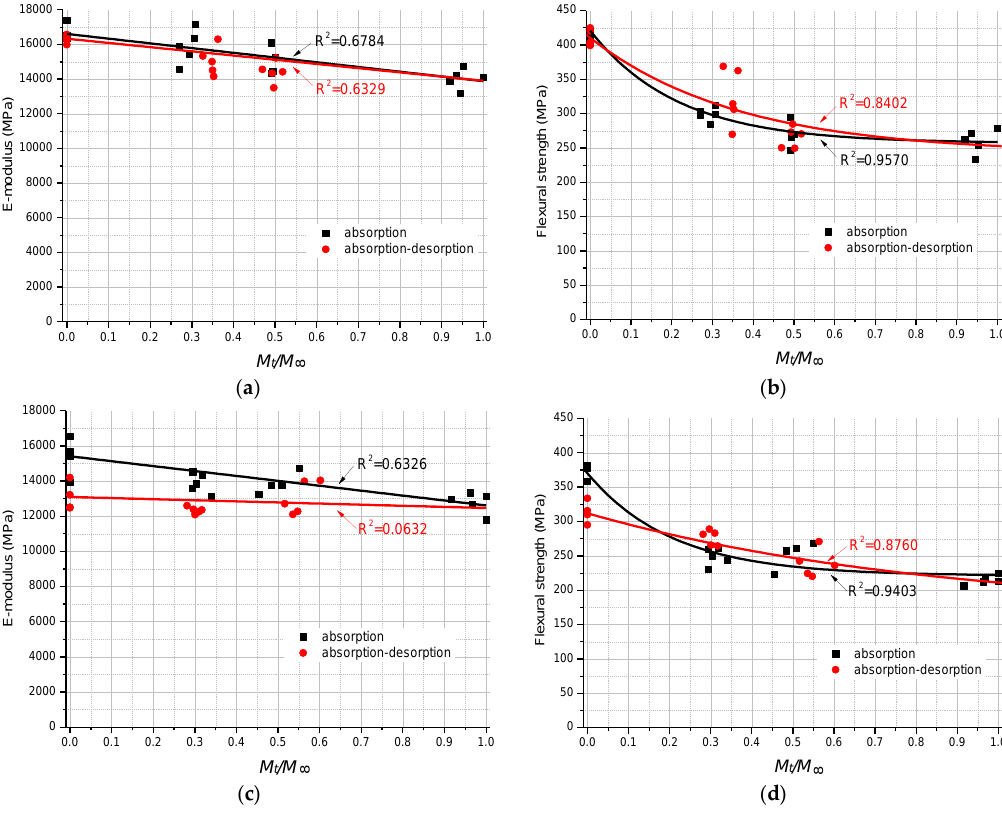
Figure 8. Environment-dependent flexural property degradation of FRP laminates. ( a ) E-modulus, 20 °C; ( b ) Strength, 20 °C; ( c ) E-modulus, 40 °C; ( d ) Strength, 40 °C. Table 4. Flexural property degradation of GFRP laminates.